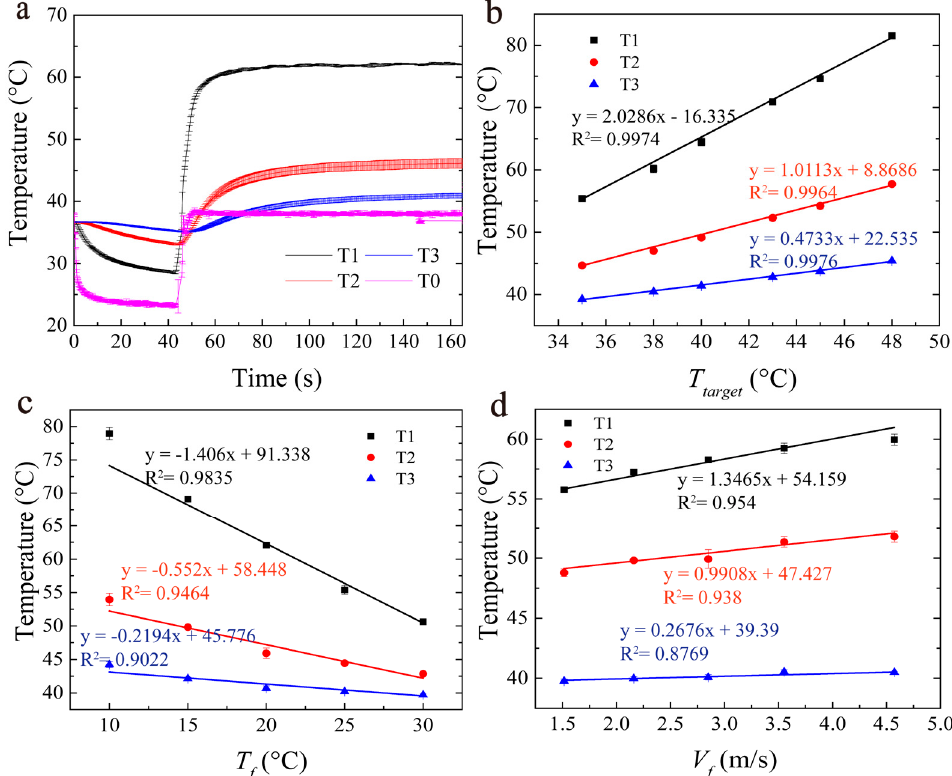
Figure 5. ( a ) The temperature evolution of T0 and T1–T3 in the phantom ( T target = 38 °C, T f = 20 °C, V f = 2.85 m/s). ( b – d ) T1–T3 in the equilibrium stage vs. the three control parameters: T target , T f, and V f . ( b ) The target temperature ( T f = 15 °C, V f = 2.85 m/s), ( c ) the cooling water temperature ( T target = 38 °C, V f = 2.85 m/s), and ( d ) the cooling water velocity ( T target = 38 °C, T f = 20 °C). T1, T2, and T3: the temperatures measured by TC1, TC2, and TC3. T0: the temperature at the control point. All of the data were collected in triplicate and expressed as the means ± SDs.